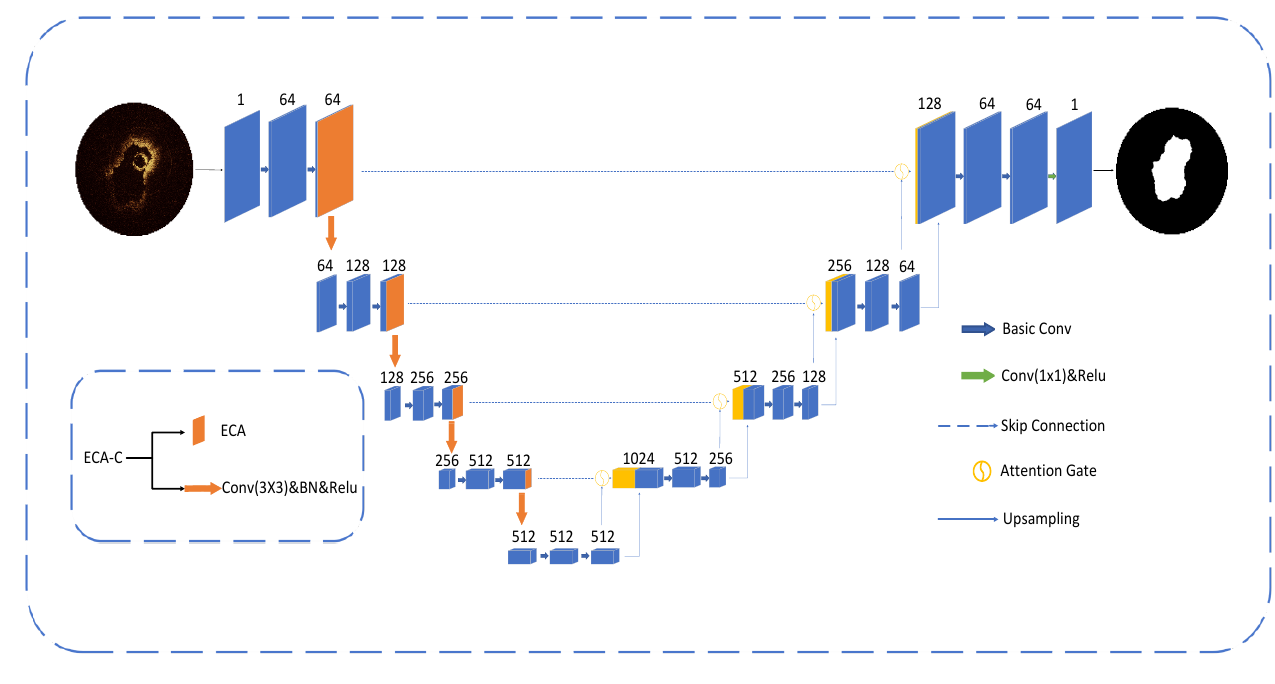
Figure 1. EA-UNet network structure.